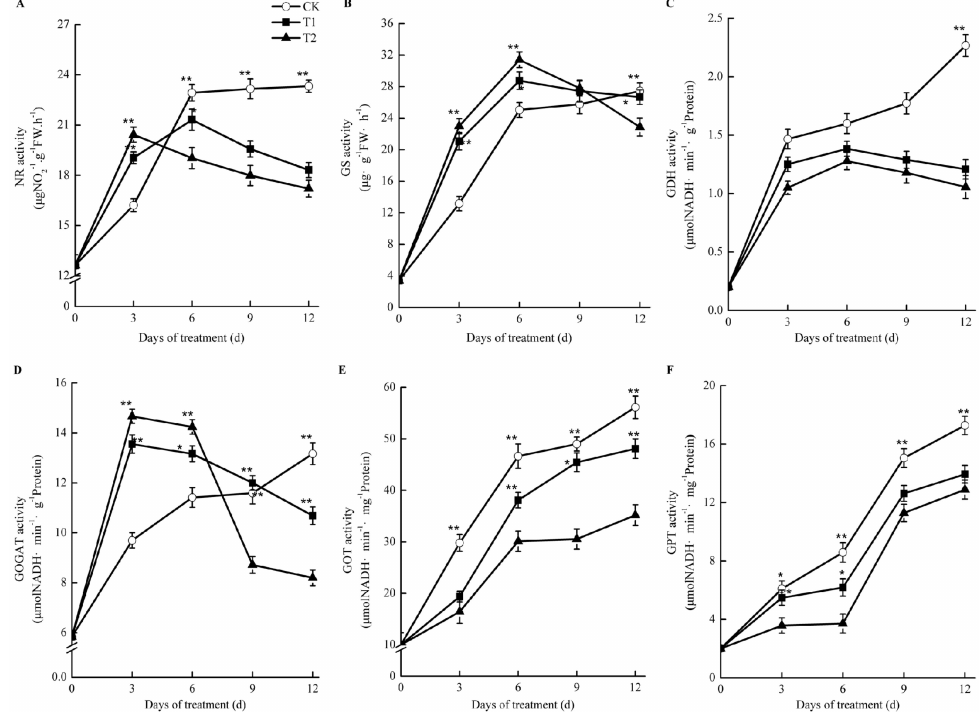
Figure 8. E ff ects of root-zone CO 2 concentration on the activity of nitrogen metabolism enymes of oriental melon seeding roots. ( A ) nitrate reductase (NR). ( B ) glutamine synthetase (GS). ( C ) glutamate dehydrogenase (GDH). ( D ) Glutamate synthase (GOGAT). ( E ) glutamic acid oxaloacetate transa-minase (GOT) and ( F ) glutamic acid-pyruvic acid transaminase (GPT). The error bars represent standard error (SE) of the means. Significant di ff erences between control and treatment are marked with asterisks (* represents p < 0.05 and ** represents p <